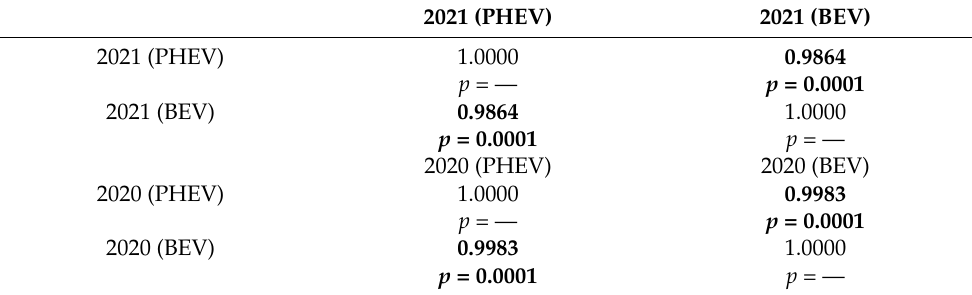
Table 3. Correlations, marked correlations are significant at p < 0.0500, n = 28 (Casewise deletion of missing